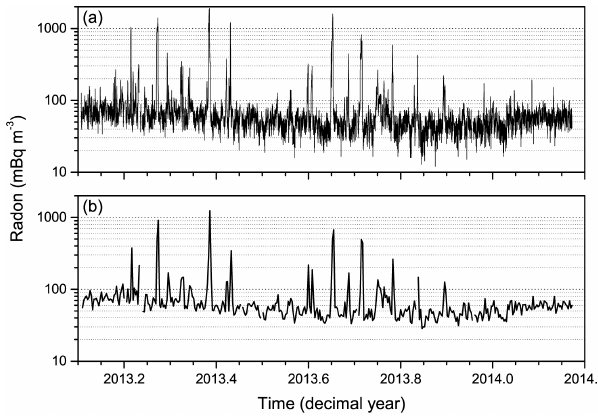
Figure 6. (a) Hourly and (b) daily-mean radon concentrations at King Sejong station. Note logarithmic